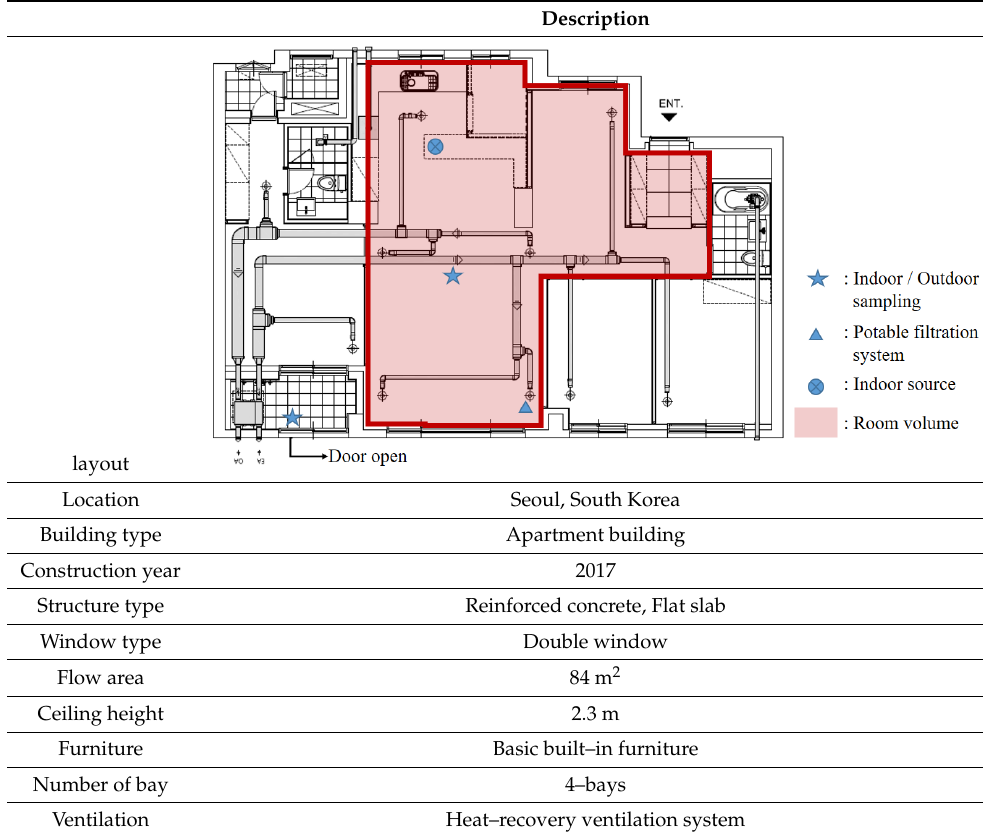
Table 1. Description of test house.